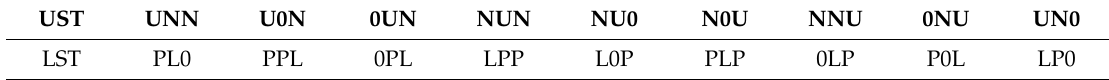
Table 2. Upper shoot-through (UST) and lower shoot-through (LST) states.